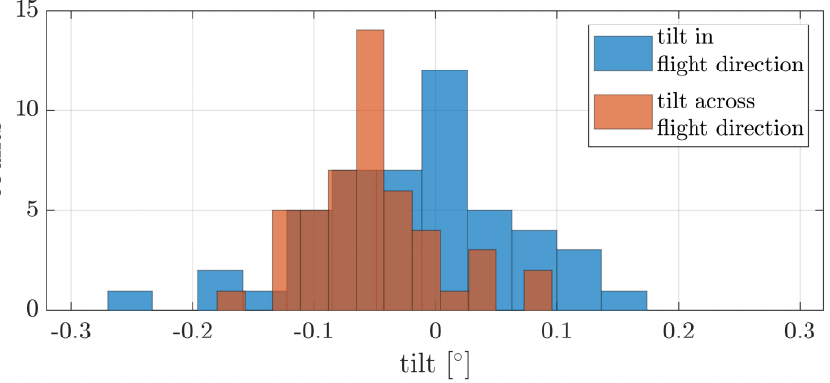
Figure 10. Tilt of planes estimated from UAV point cloud compared to the TLS reference in flight and across flight direction.